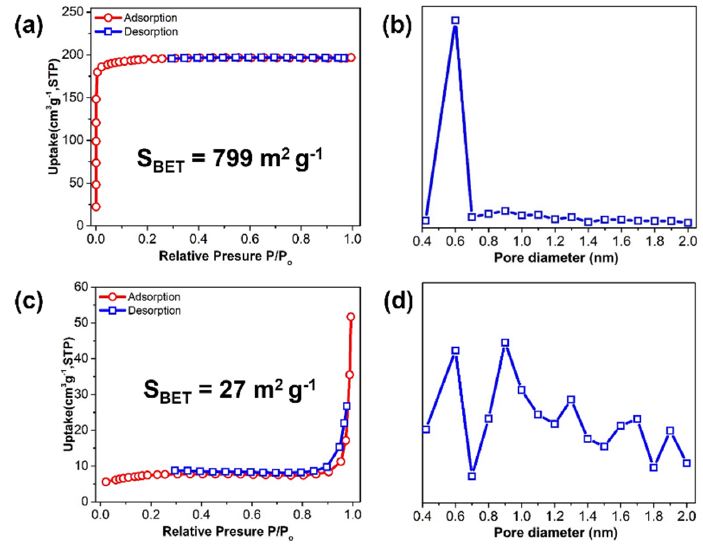
Figure 4. Scanning electron microscopy (SEM) images of ( a ) micro-sized Cu-BTC ( 1 ), ( b ) nano-sized